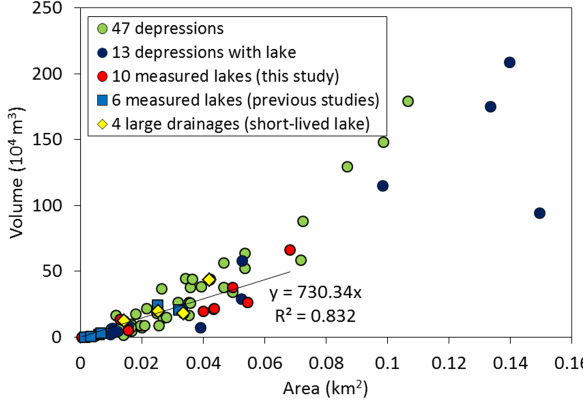
Figure 9. Volume and area of directly measured lakes and depres- sions. Thirteen depressions have an existing glacial lake. Five de- pressions have a lake area of more than 30% of the maximum filling area possible. (Data from six previously studied lakes, this study, and Igor Severskiy, personal communication, 2009; Janský et al.,